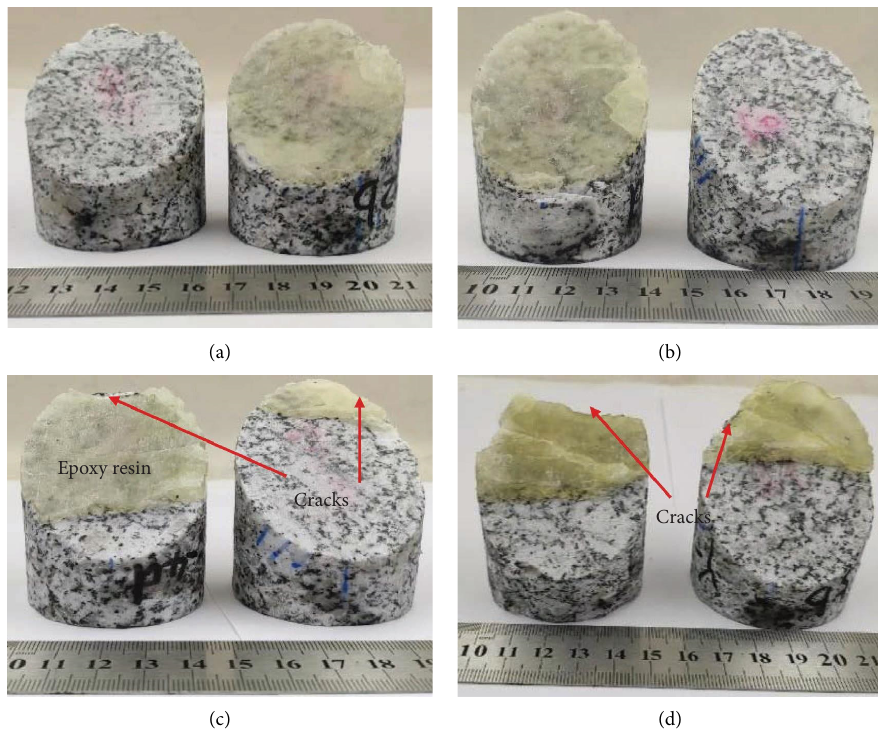
Figure 25: Epoxy resin-repaired samples with diferent repair widths (a) 1mm; (b) 3 mm; (c) 5mm; and (d) 7 mm after failure at day 28.